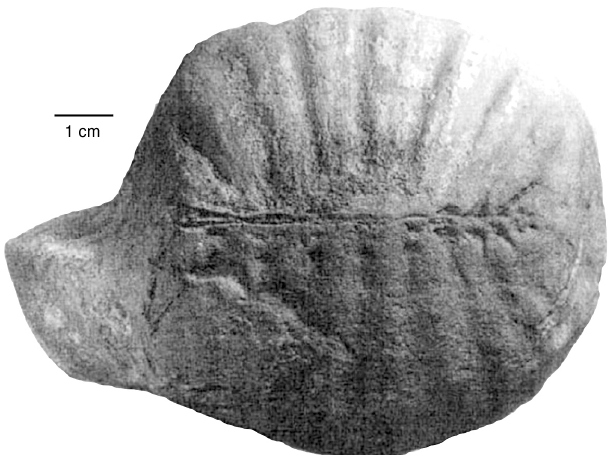
Figure 5. Cast of a carapace of an early Eocene trionychid turtle from the Chuckanut Formation near Bellingham, Washington USA. Adapted from [17].